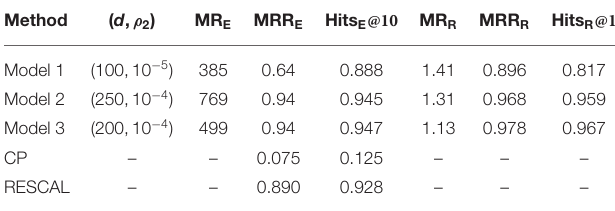
TABLE 1 | Results for WordNet data